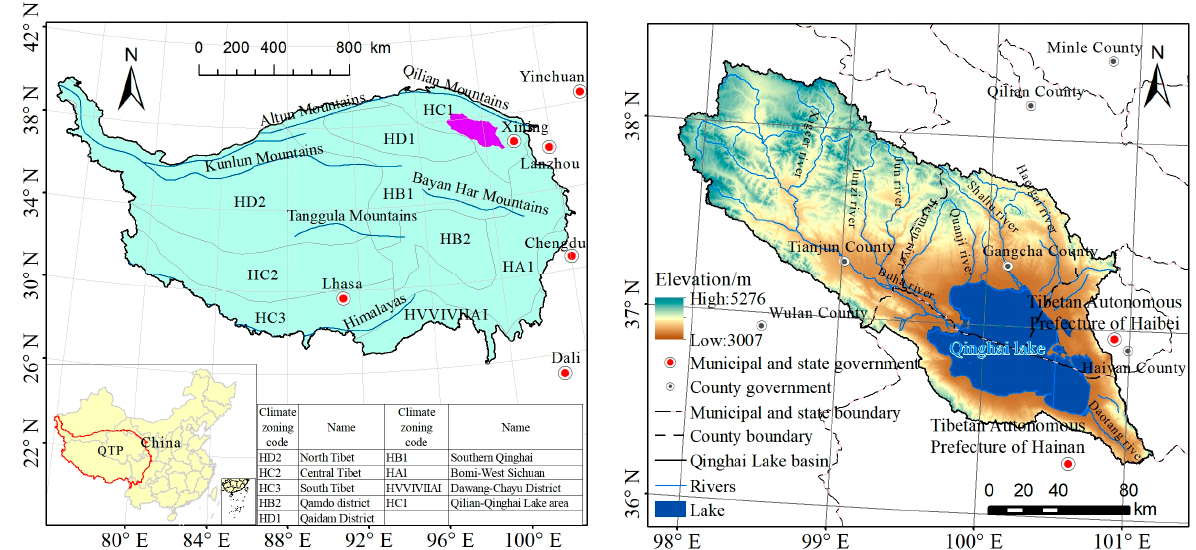
Figure 1. Geographical location map of the study area.